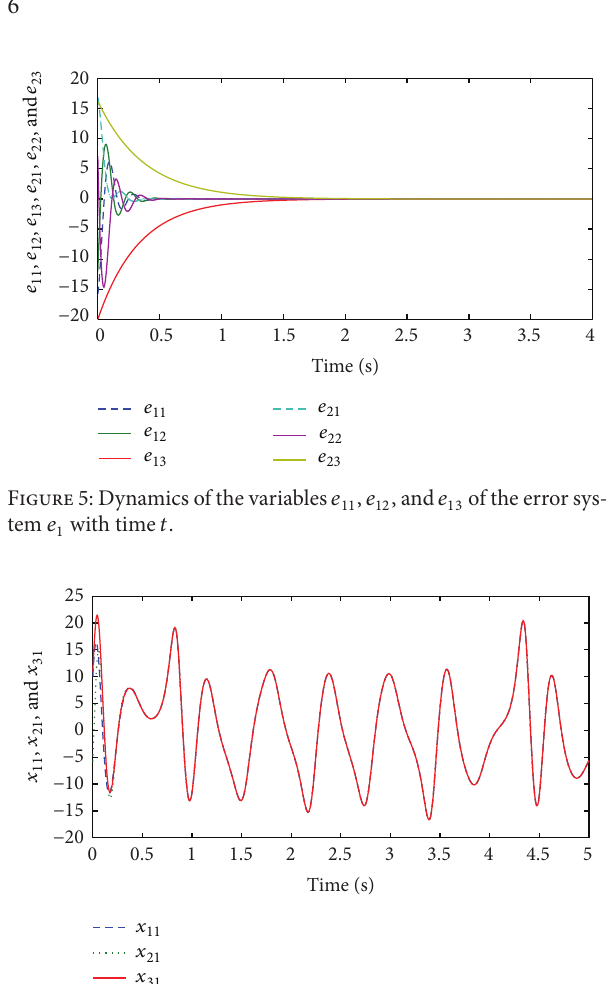
Figure 6: The state trajectories 𝑥 11 , 𝑥 21 , and 𝑥 31 of the chaotic sys- tems with time 𝑡 .